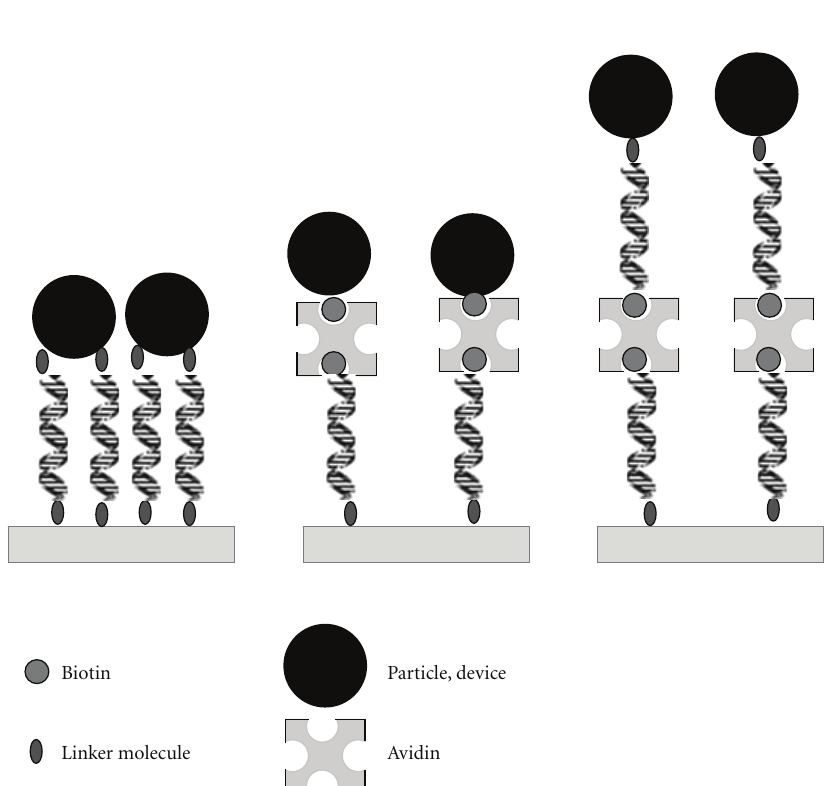
Figure 4: Single stranded DNA and quantum dot as building blocks for the construction of complex 3-dimensional structures which can be used for biosensors. ( Source : Schmid et al ., Nanotechnology assesments and prospective , 2006 , Springer